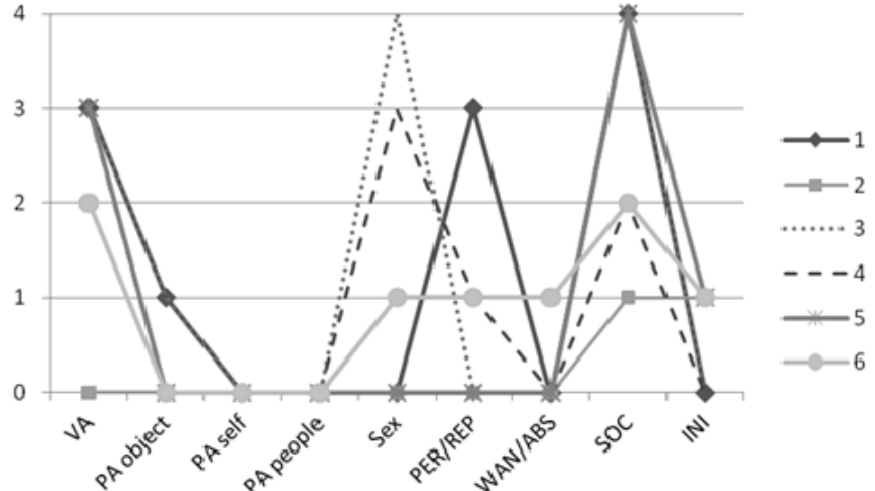
Figure 1. Maximum level of severity (from 0 to 4) for each TBI-ISB subject’s behavior on the Overt Behavior Scale